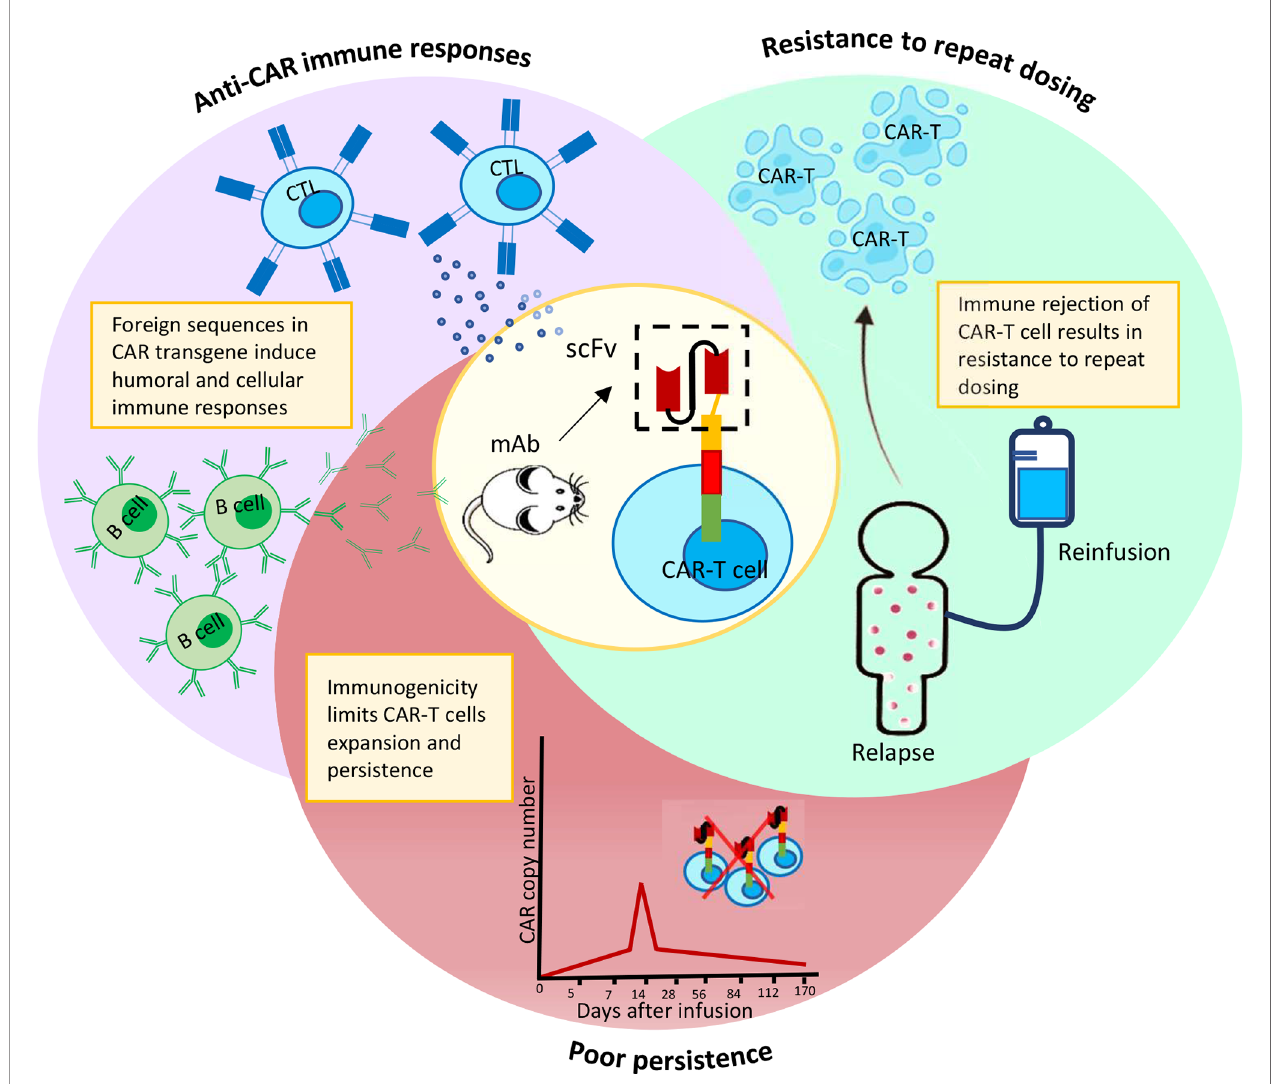
FIGURE 1 | Immuno-activation by murine scFv results in CAR-T cells elimination prematurely and resistance to repeat